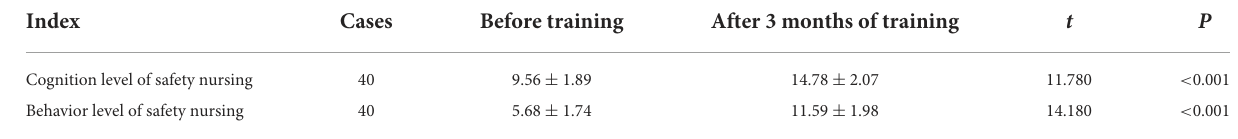
TABLE 1 Comparison of nurses’ cognition and behavior level of enteral nutrition before and 3 months after training (x ± SD, scores). Index